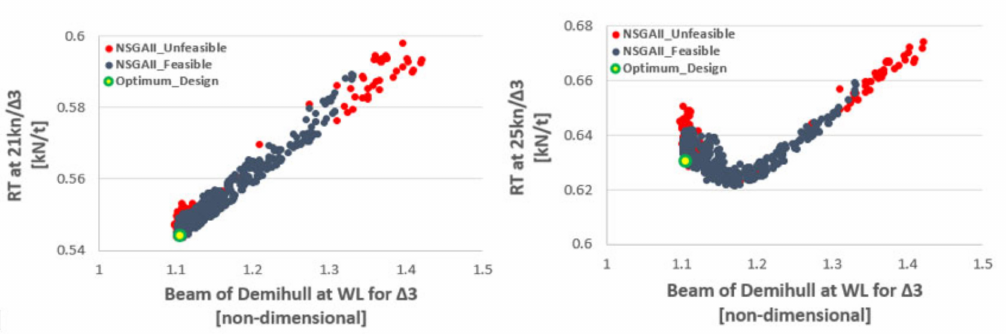
Figure 8. Typical calm water resistance per ton of displacement against non-dimensional beam at WL for 21kn (left) and 25 kn (right)